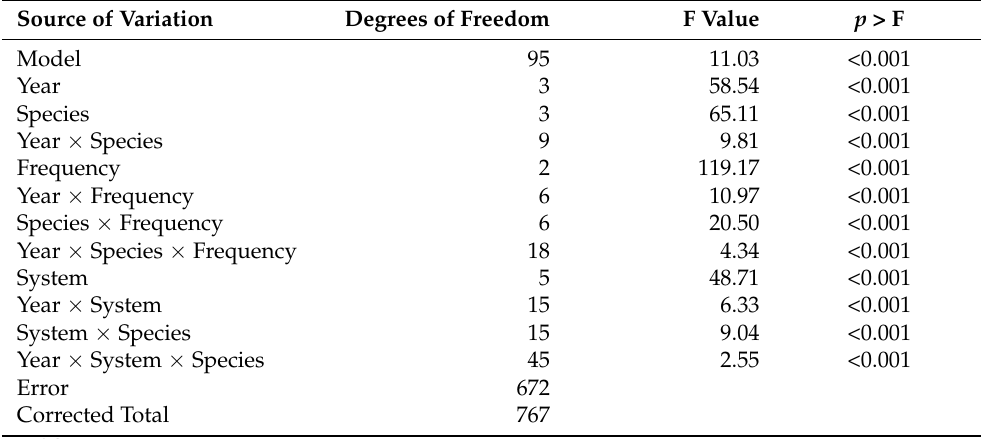
NWSG = native warm-season